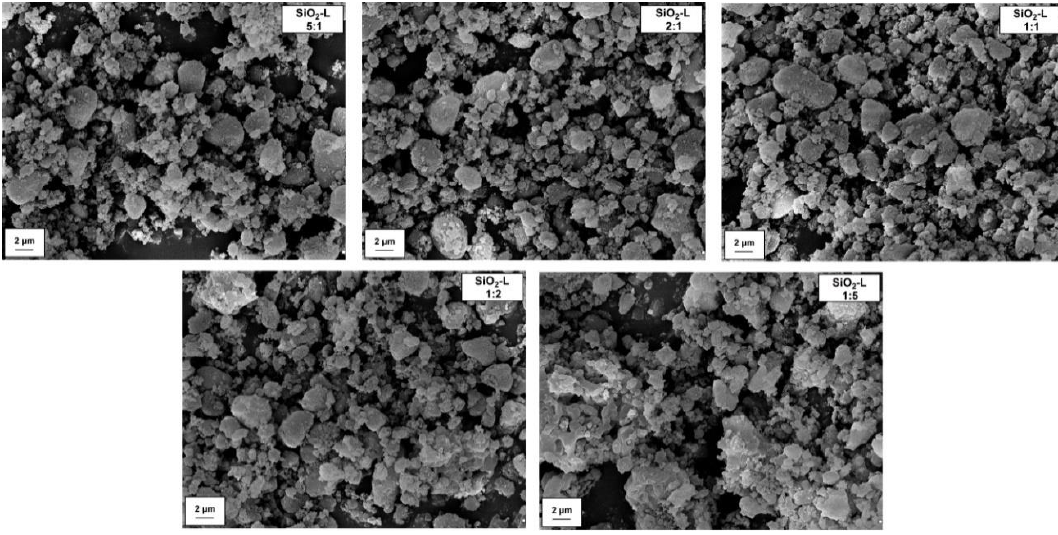
Figure 3. SEM microphotographs of silica-lignin hybrid materials with different weight ratios of the components used.